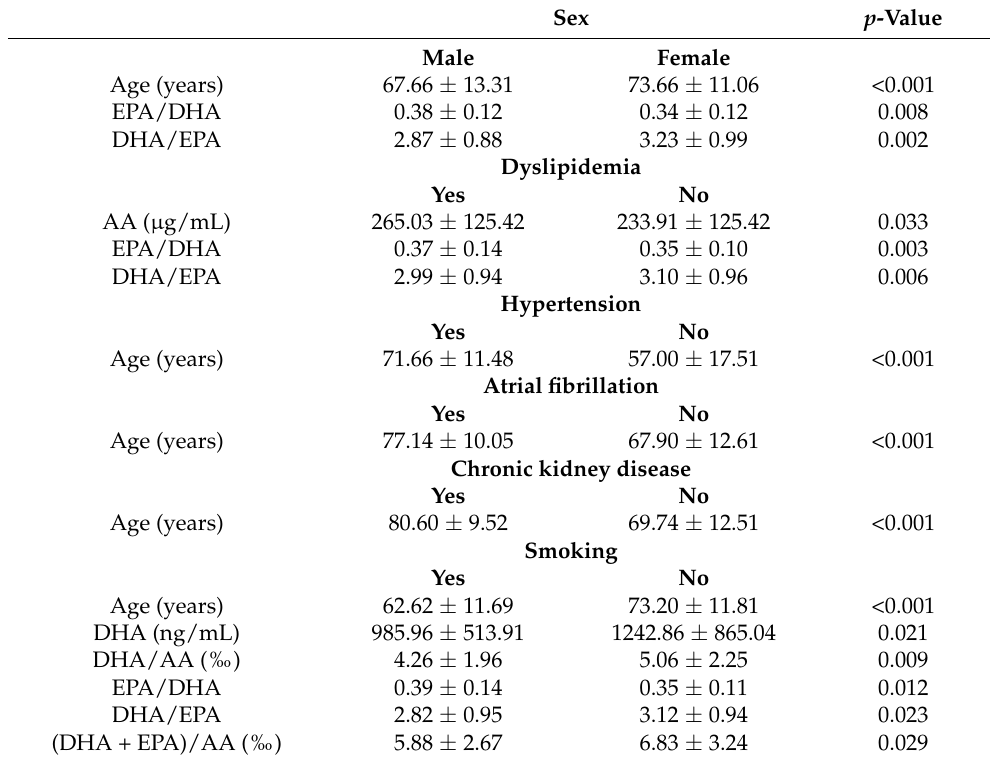
Table 5. Study population ANOVA